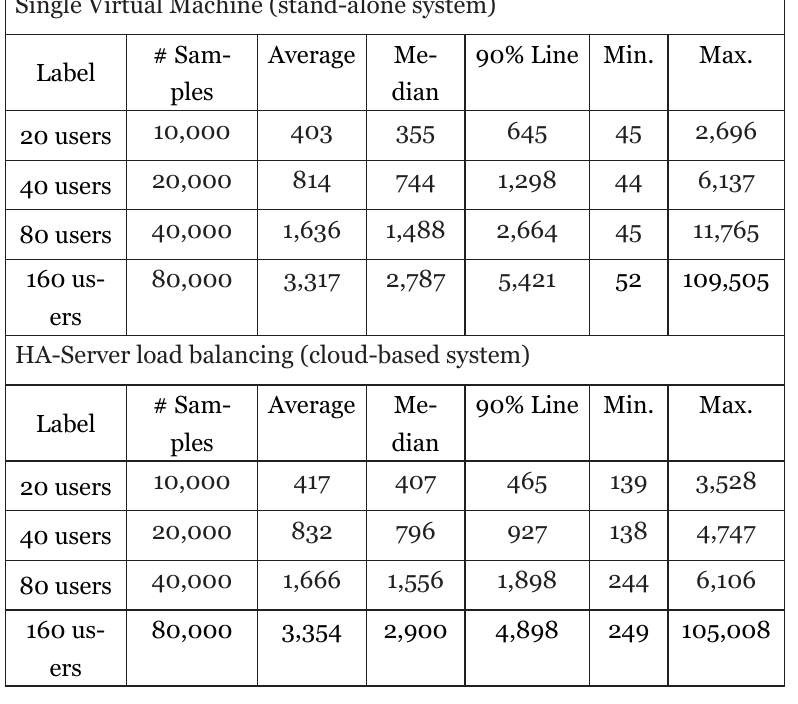
Table 2 Simulation Results, with Response Times in Milliseconds